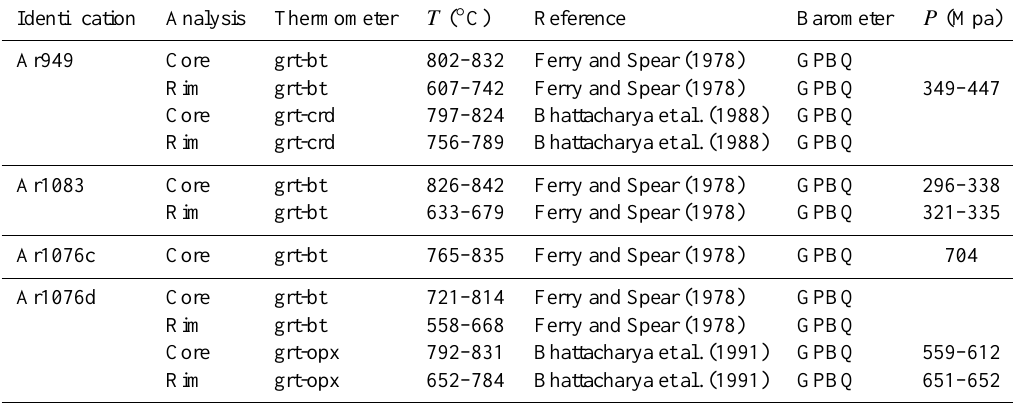
Table 2. Summarized geothermobarometric results for the studied rocks.